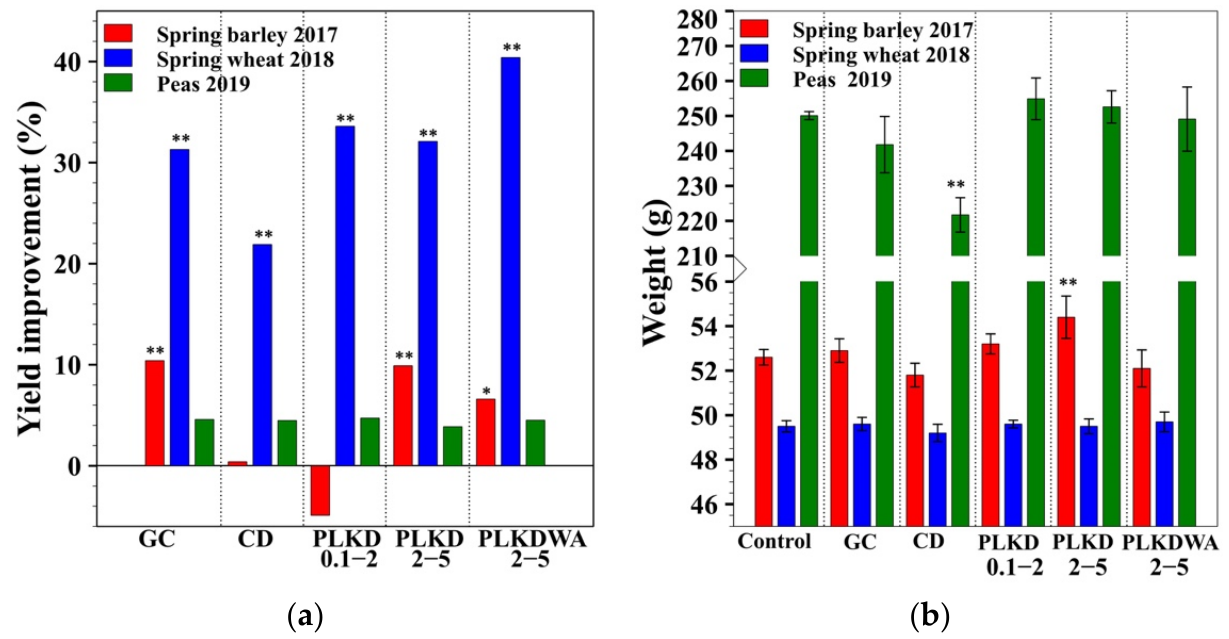
Figure 6. ( a ) The yield of spring barley, spring wheat and peas; ( b ) 1000-grain weight of spring barley, spring wheat and 1000-seed weight of peas. * and ** indicate significant differences accord- ing to Fisher’s least significant difference test. Statistically significant at * p < 0.05 and ** p < 0.01 level.